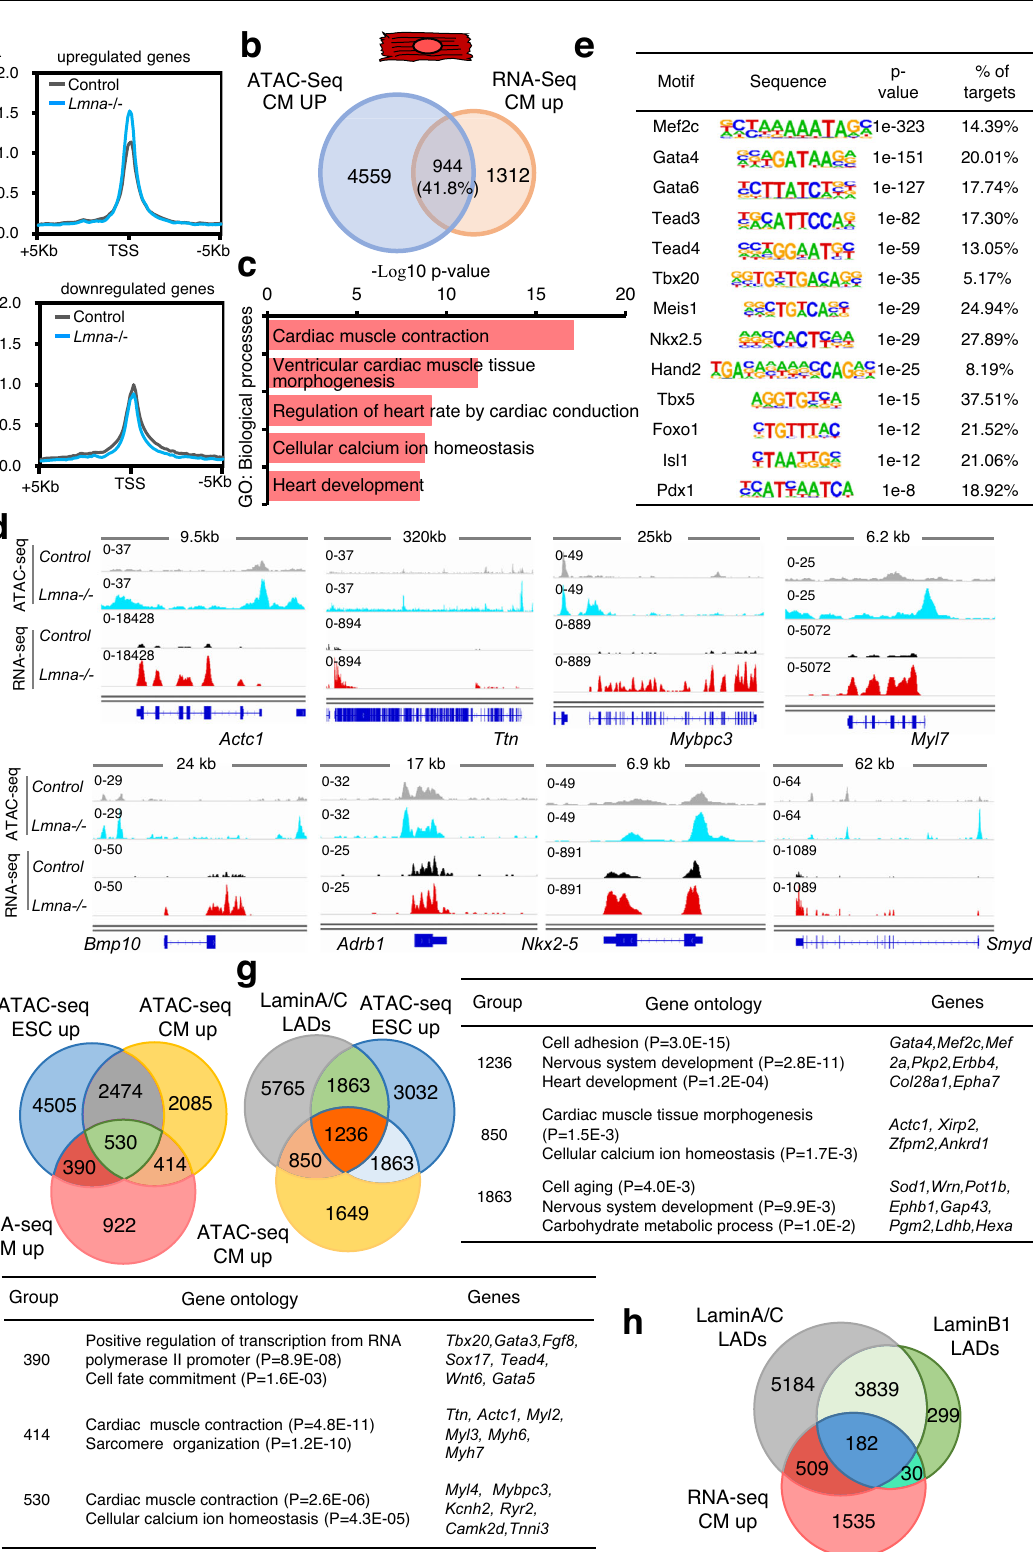
Cardiac muscle tissue morphogenesis 850 (P=1.5E-3) Cellular calcium ion homeostasis (P=1.7E-3) 1863 Cell aging (P=4.0E-3) Nervous system development (P=9.9E-3) Carbohydrate metabolic process (P=1.0E-2)